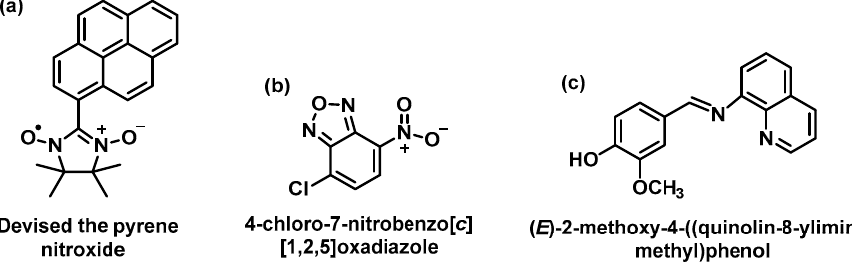
Figure 64. Structure of pyrene-derived probes nitroxide ( a ), oxadiazole ( b ), and imine derivative ( c ). The 4-chloro-7-nitrobenzo [c] (1,2,5) oxadiazole probe is commercially available and